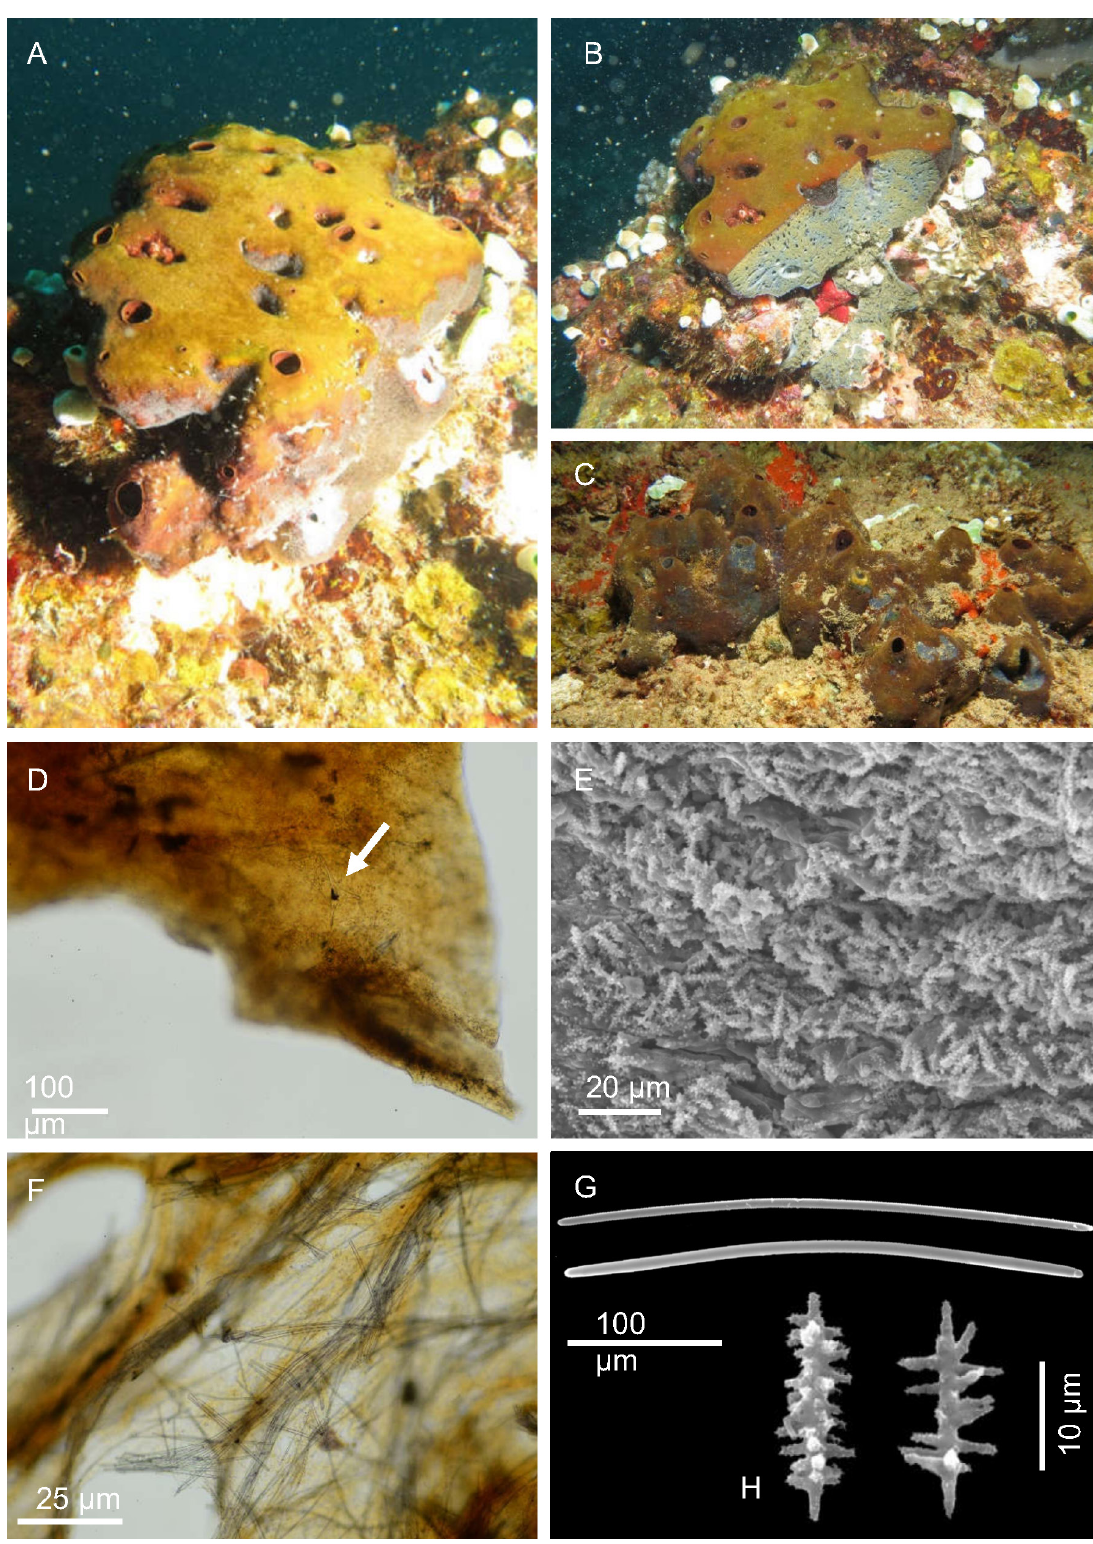
Fig. 13. Theonella conica (Kieschnick, 1896). A–B . The specimen PO2 in situ ; in B a fresh cut highlights the blue colored choanosome. C . The specimen PO29 in situ . D . Ectosome with phyllotriaene (arrow) and rhabds. E . Crust of rhabds (SEM). F . Choanosomal skeleton. G . Strongyles. H . Straight